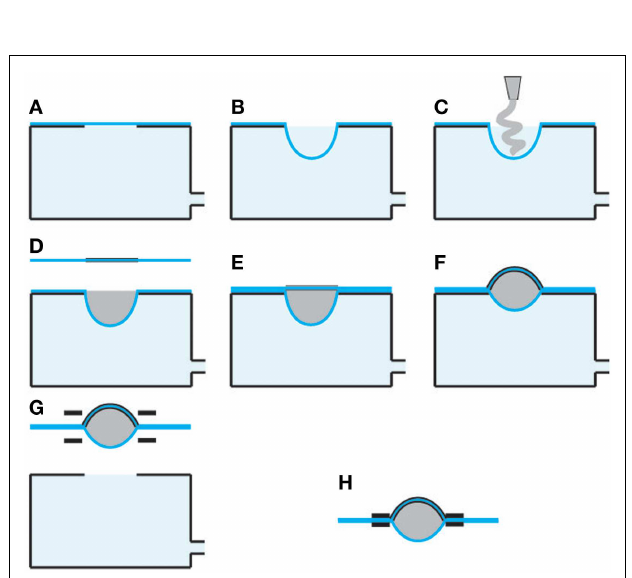
FIGURE 2 | Schematic drawings of the proposed fingertip wearable tactile display .